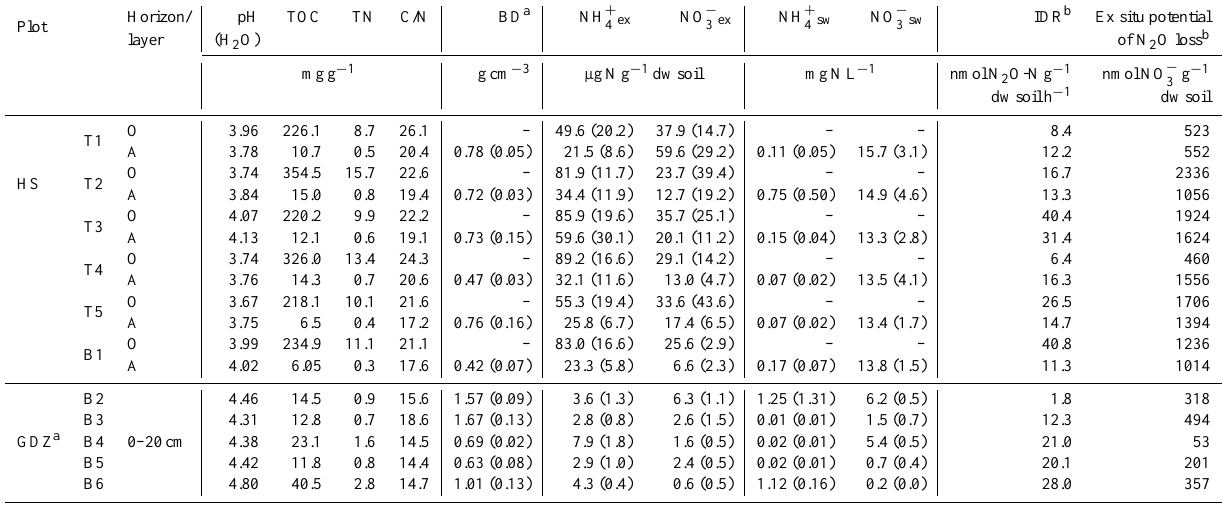
Table 1. Characteristics of top soils at individual plots on the hillslope (HS) and in the groundwater discharge zone (GDZ). Horizon/ pH TOC TN Plot